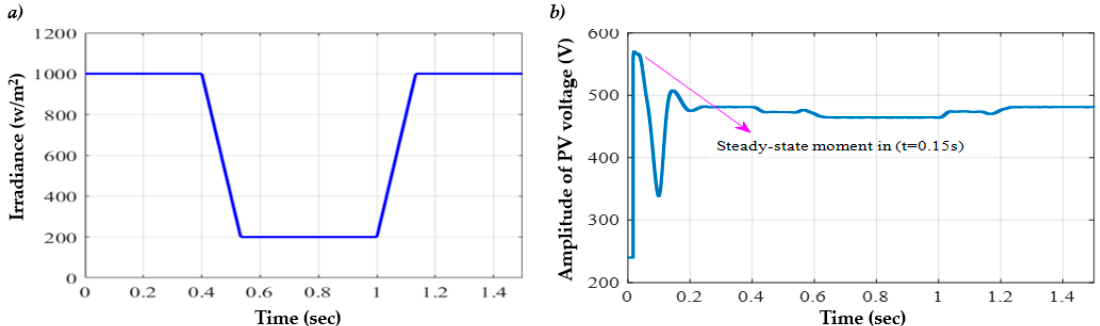
Figure 2. ( a ) Solar irradiance value when the PV module temperature is at 45 °C; ( b ) Observed PV array voltage variations with the change in input solar irradiance values.